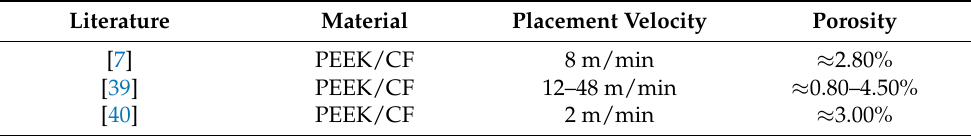
Table 3. Porosity level of PEEK/CF specimens manufactured by laser-based